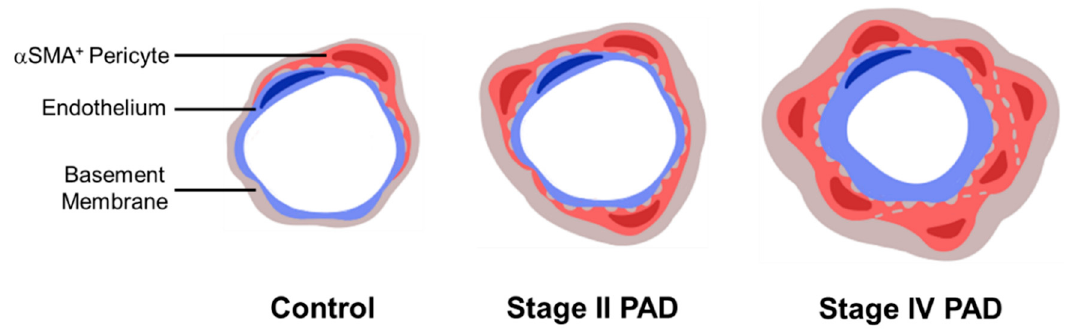
Figure 10. Schematic representation of micro-vessel remodeling in PAD.